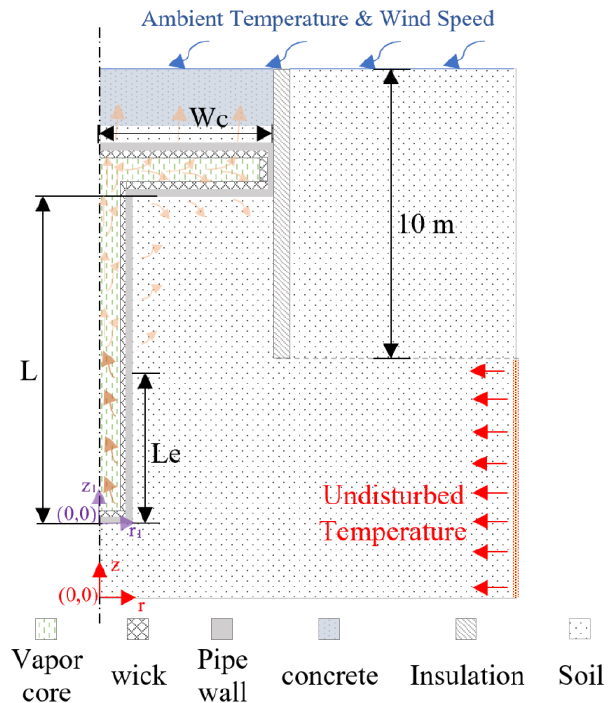
Figure 1. Schematic of the CO2-GSHP domain.